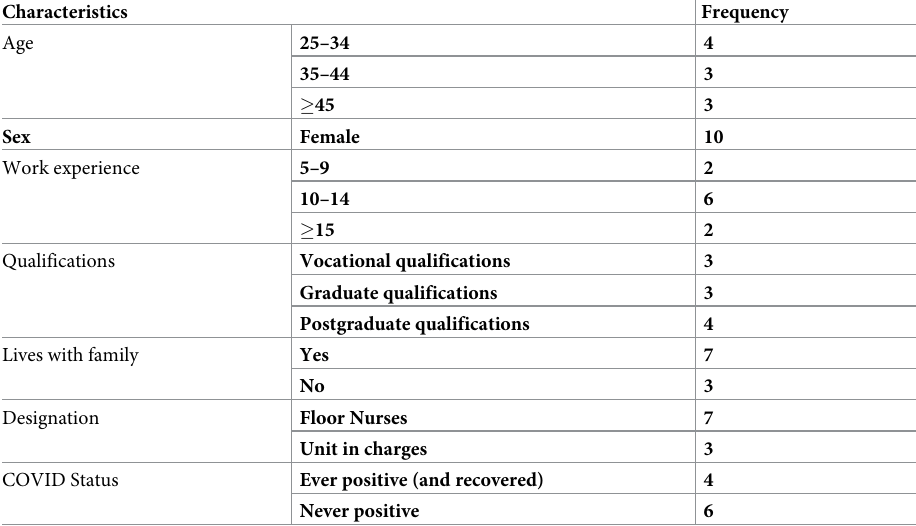
Table 1. Socio-demographic characteristics of